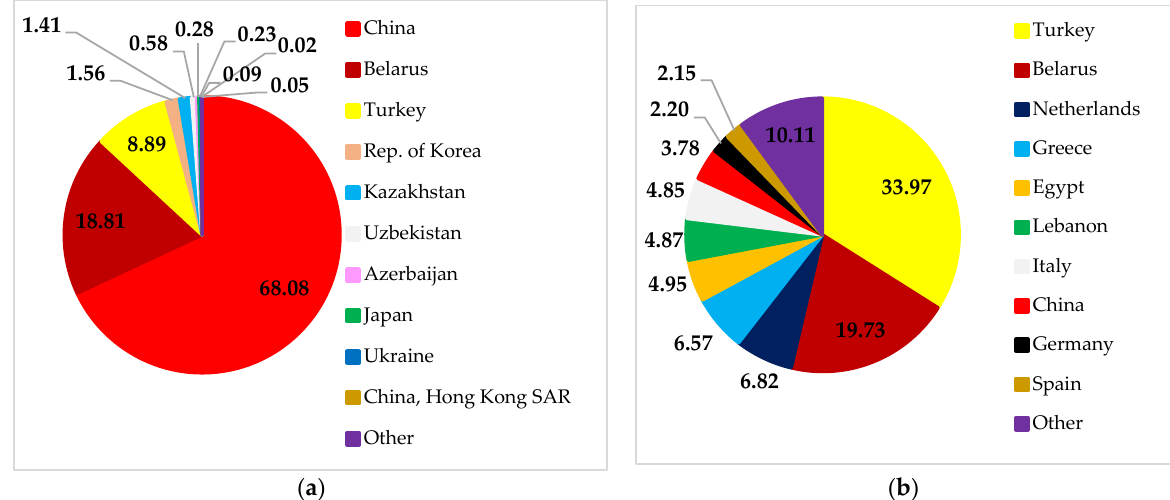
Figure 10. Destinations for Russian ( a ) and Ukrainian ( b ) soybean exports. Source: [30]. The role of Ukraine and Russia was seen to be significant in fulfilling Belarusian im- port demands for soybeans (Figure 11). More soybeans are imported into Belarus from Ukraine than from Russia. On the other hand, both countries’ contributions to fulfilling China’s and Turkey’s demands were less significant. Ukraine met the needs of 20.21% and 0.06%, while Russia met 2.17% and 0.69%, respectively.